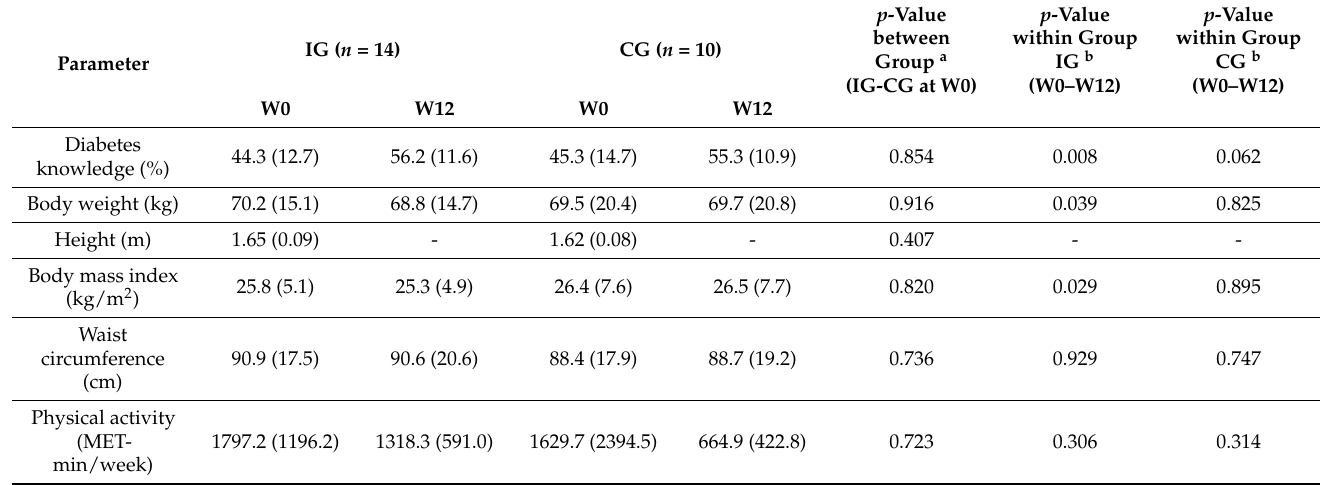
Table 2. Changes in diabetes knowledge and lifestyle practices among the participants ( n =